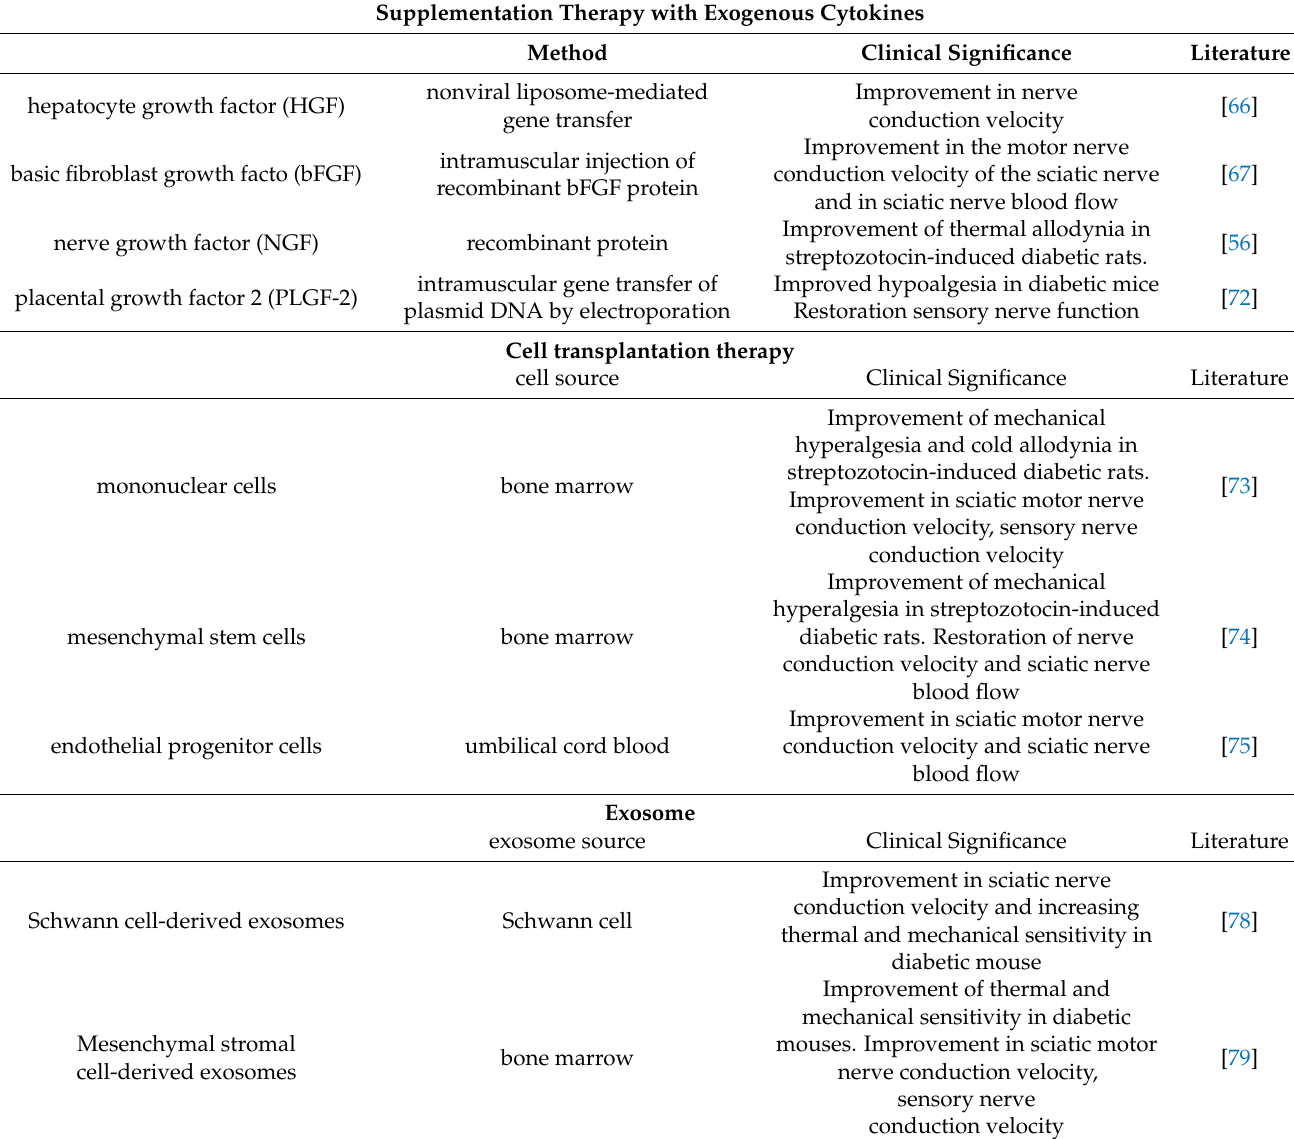
Table 2. Regenerative medicine mentioned in this